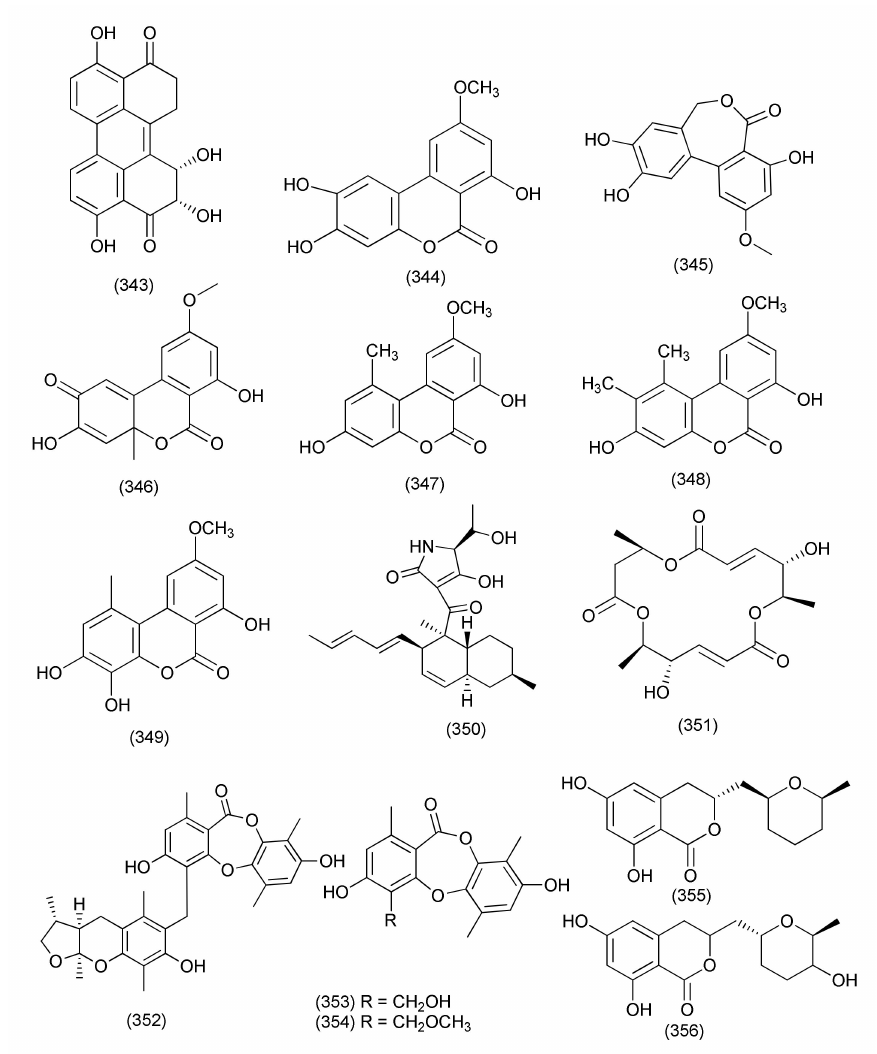
Figure 19. Structures of metabolites 343 – 356 isolated from Anamorphic